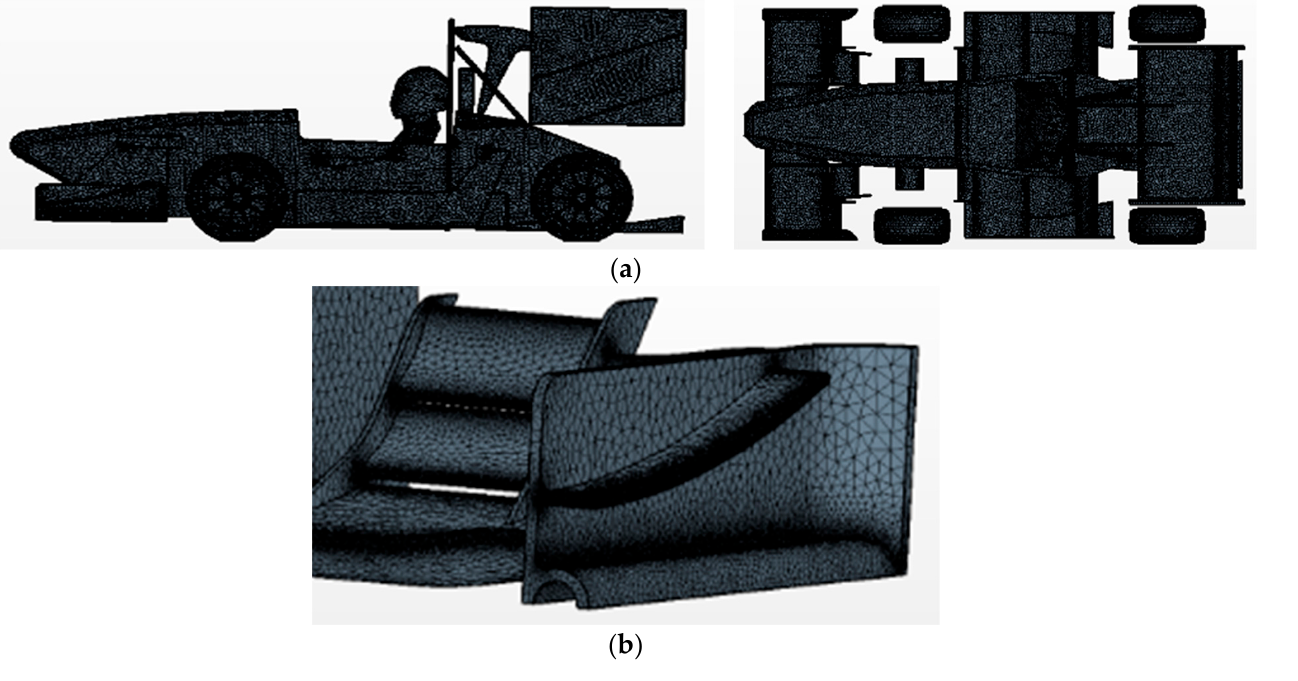
Figure 2. Surface mesh and local detail surface mesh of simplified racing model: ( a ) vehicle surface grid and ( b ) front wing local surface mesh.